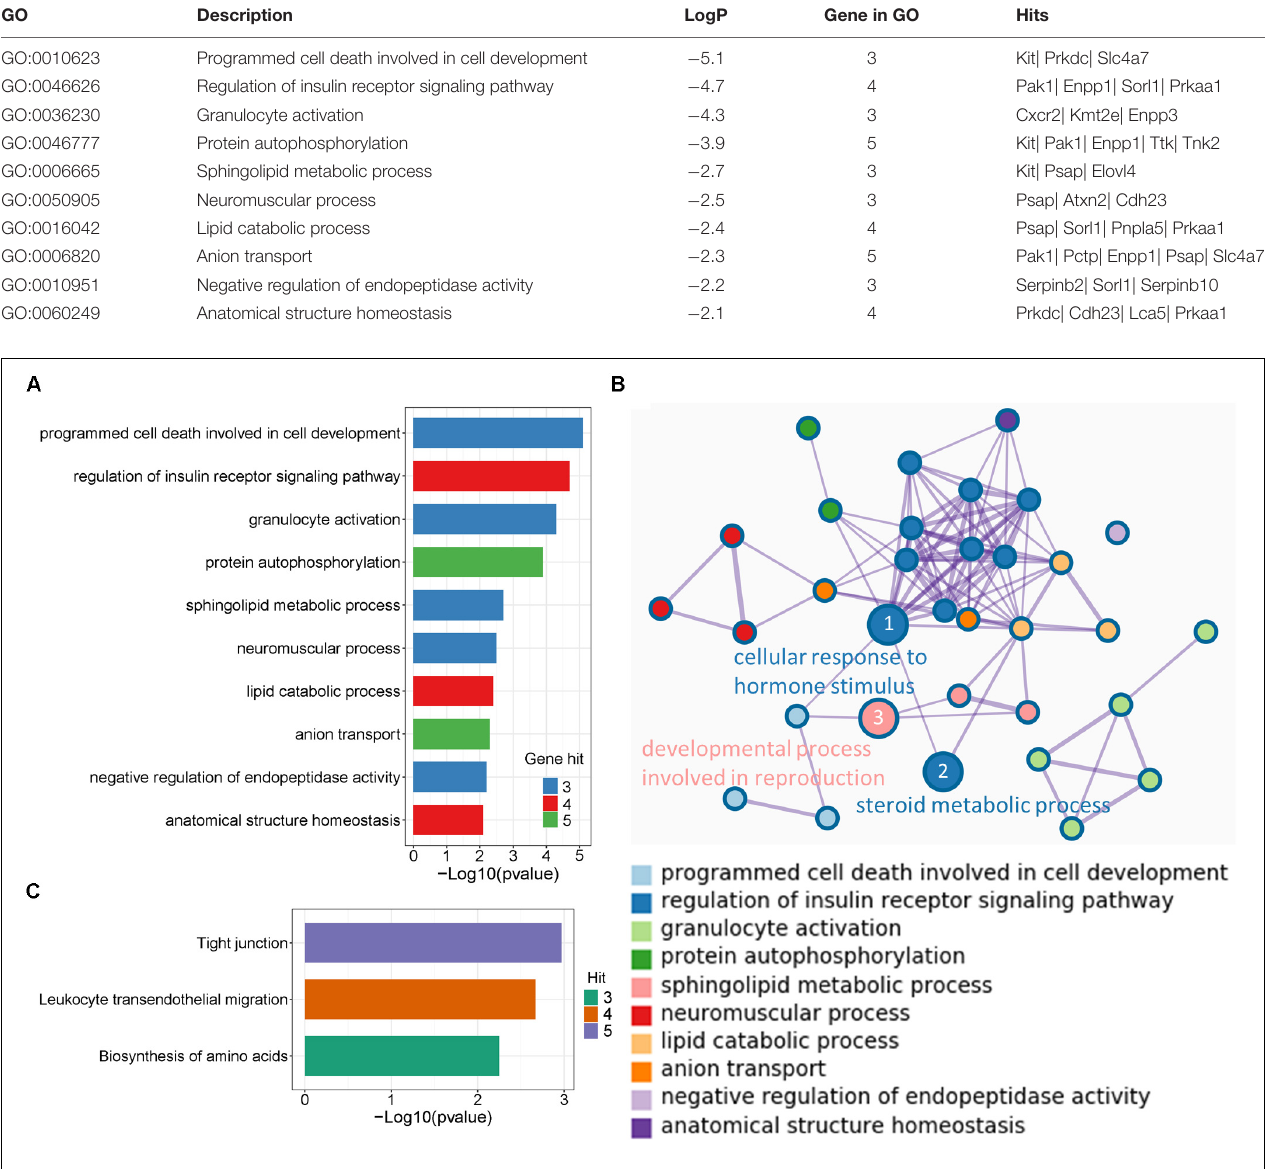
FIGURE 5 | Enrichment analysis of candidate genes. (A) The top non-redundant go enrichment clusters of genes in selected region both of LS2 vs LS1 and LS3 vs LS1 groups. Per cluster use a discrete color scale to represent statistical significance. (B) Metascape enrichment network showing the intra-cluster and inter-cluster similarities of enriched go terms. Node size is reflected by gene hits in the go term. (C) Enriched KEGG pathway of candidate